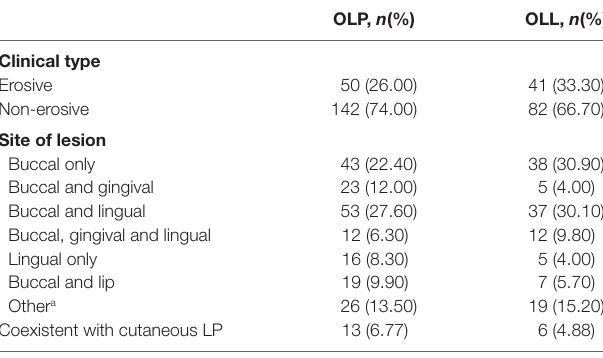
TaBle 2 | Clinical characteristics of oral lichen planus (OLP)/oral lichenoid lesion (OLL) group patients.